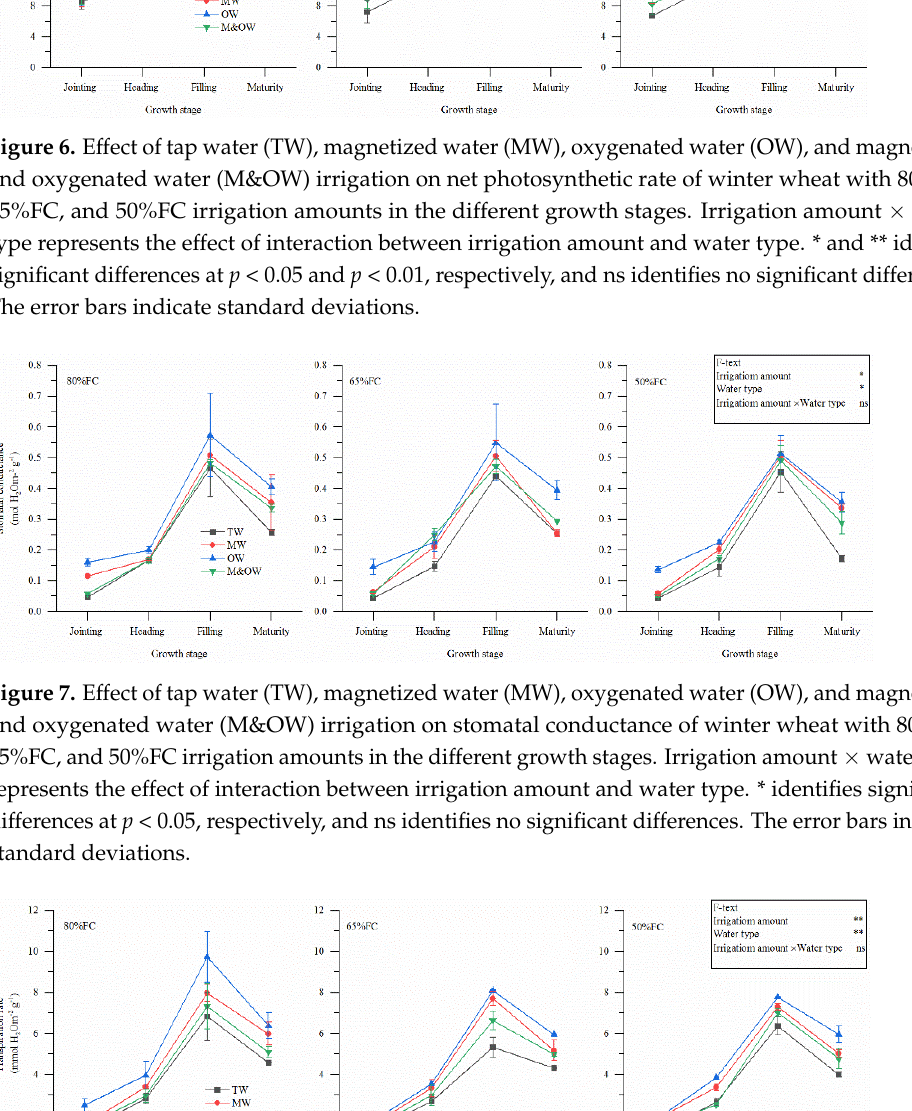
Figure 8. Effect of tap water (TW), magnetized water (MW), oxygenated water (OW), and magnetized and oxygenated water (M&OW) irrigation on the transpiration rate of winter wheat with 80%FC, 65%FC, and 50%FC irrigation amounts in the different growth stages. Irrigation amount × water type represents the effect of interaction between irrigation amount and water type. ** identifies significant differences at p < 0.01, respectively, and ns identifies no significant differences. The error bars indicate standard deviations.